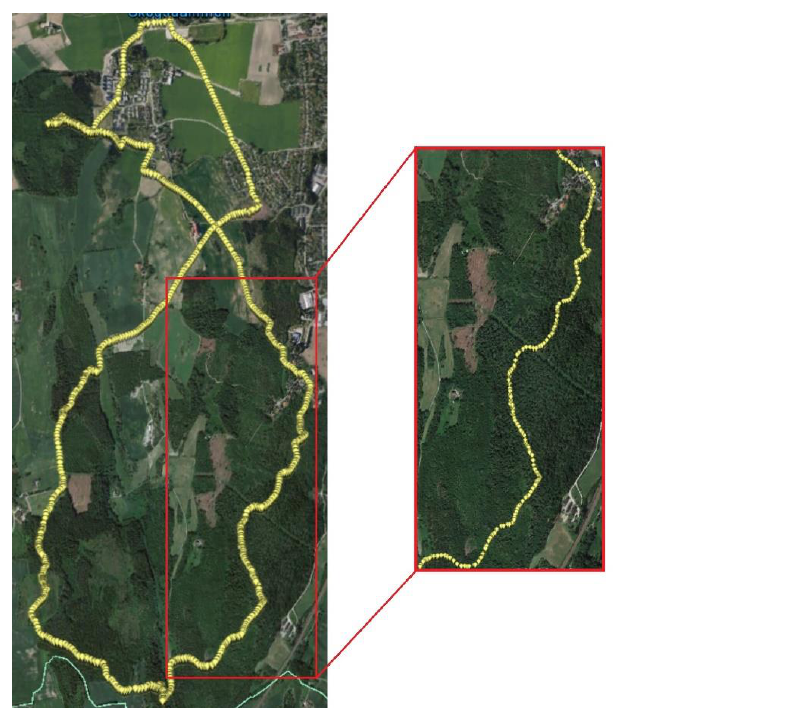
Figure 3. The path taken by an orienteering athlete. Right figure shows the path corresponded to the Section #5 in Figure 3 in more